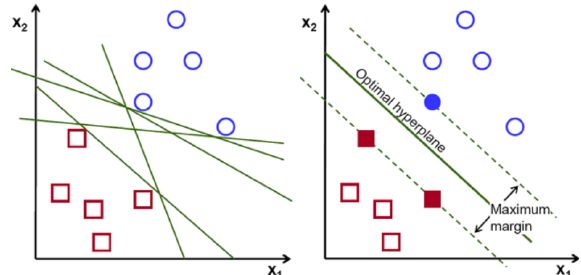
Figure 3. Support vector visualization [8].